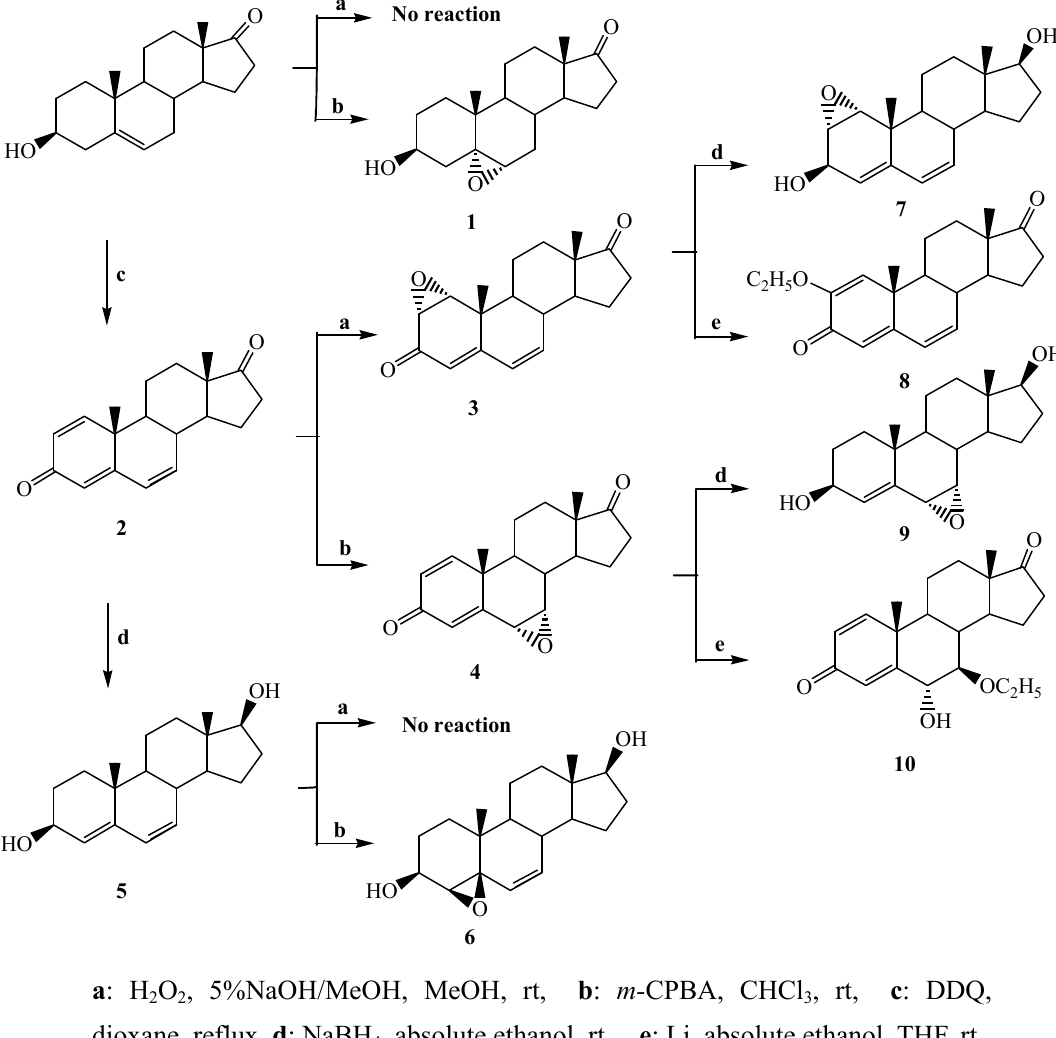
Scheme 1. Synthesis of dehydroepiandrosterone